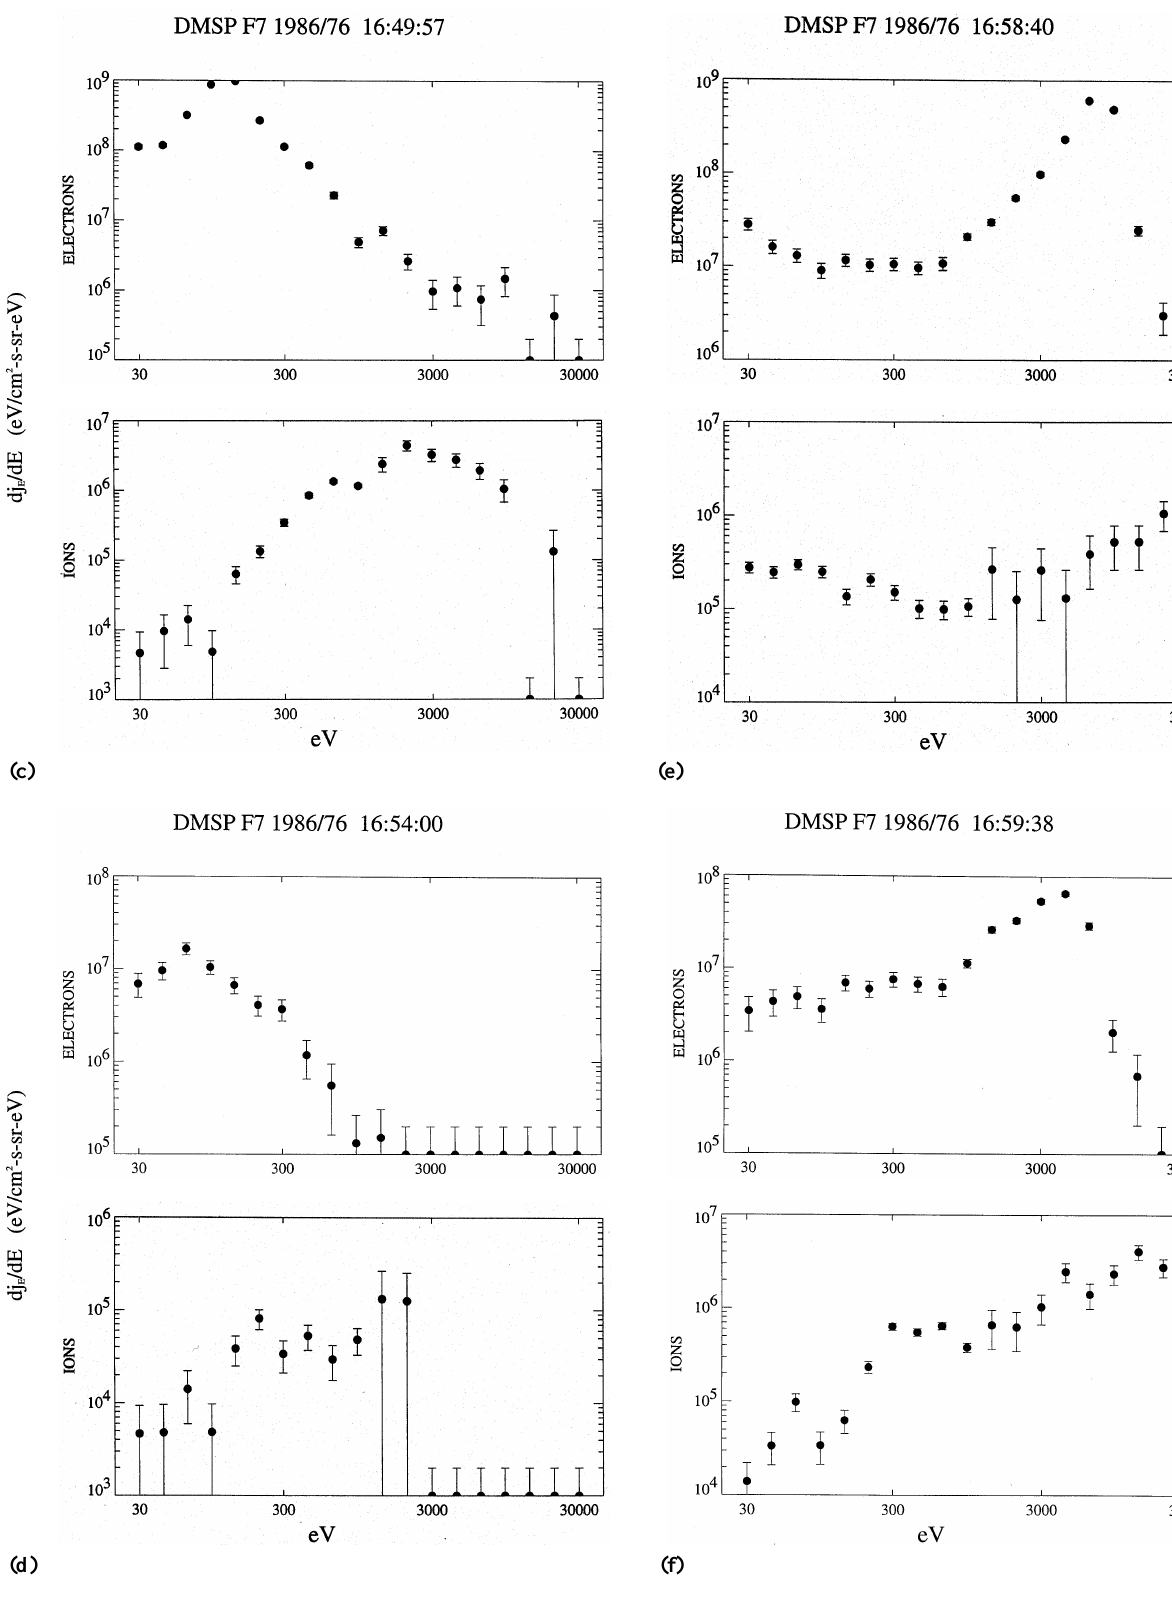
Fig. 3c-f. Electron and ion spectra observed at low altitude by DMSP F7 for the pass shown in Fig. 1. Plotted is the differential energy flux (circles with error bars) for various plasma regimes: (c) SSSL; (d) VSP; (e) AO; (f)